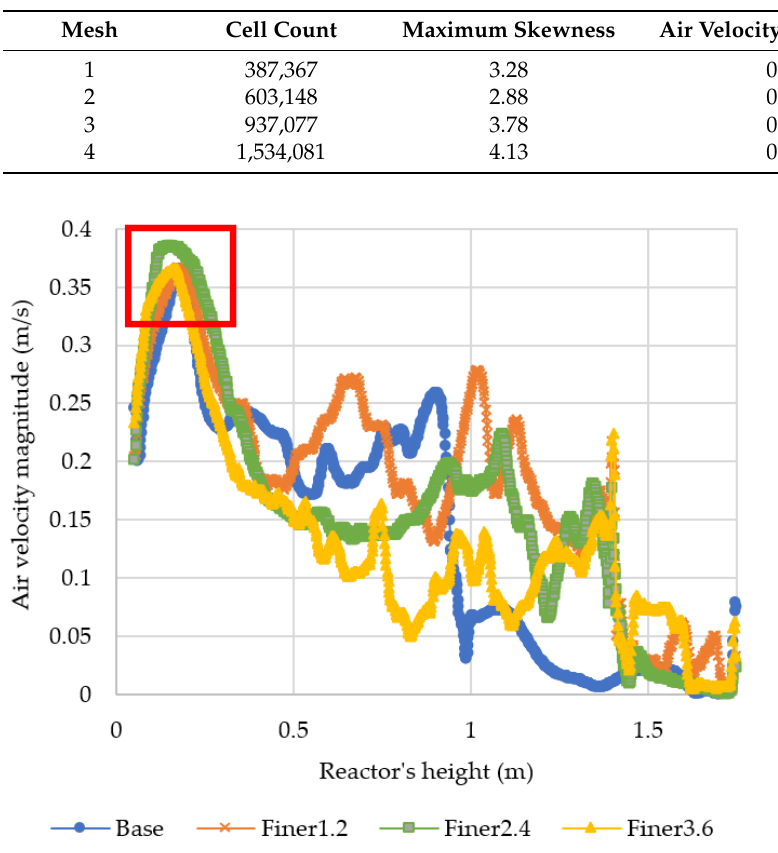
Figure 3. Air velocity magnitude from inlet to outlet. Values extracted from first peak (marked in red) for mesh study.